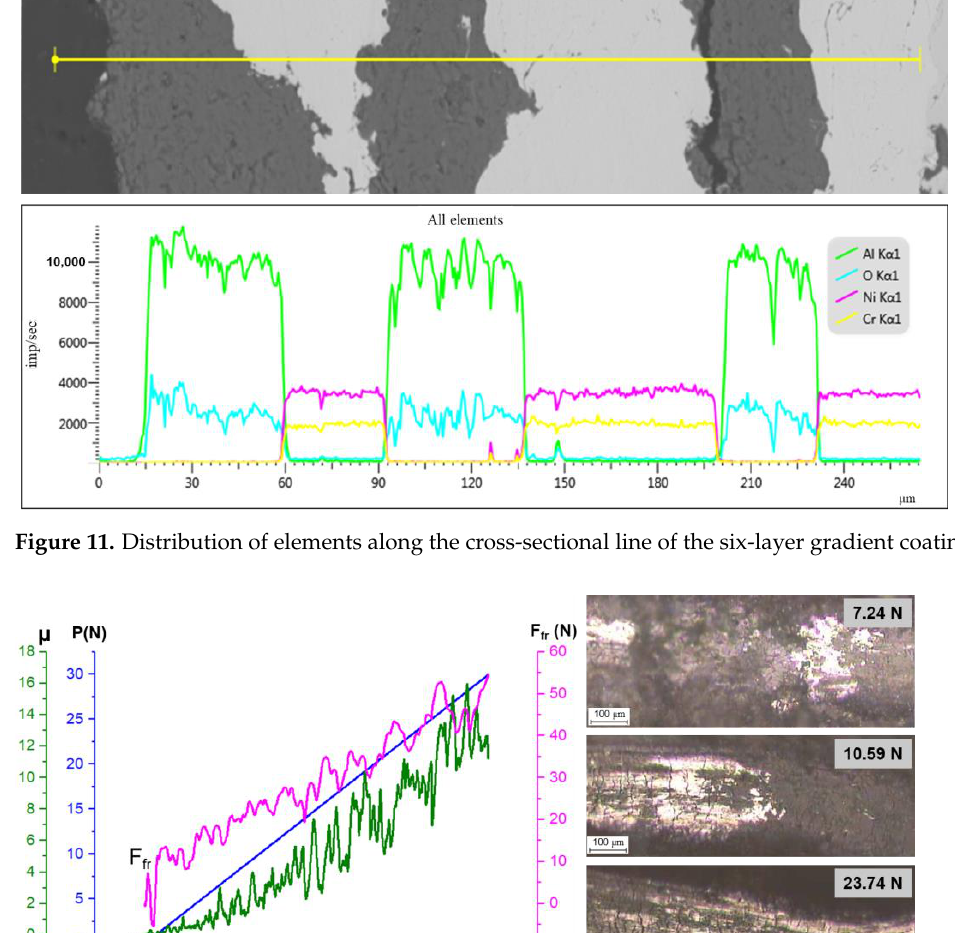
Figure 10. SEM images of the cross-section morphology of the six-layer gradient coating.